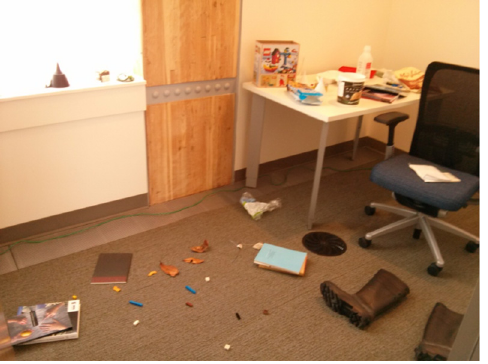
Fig 1. The room that participants were instructed to tidy up.